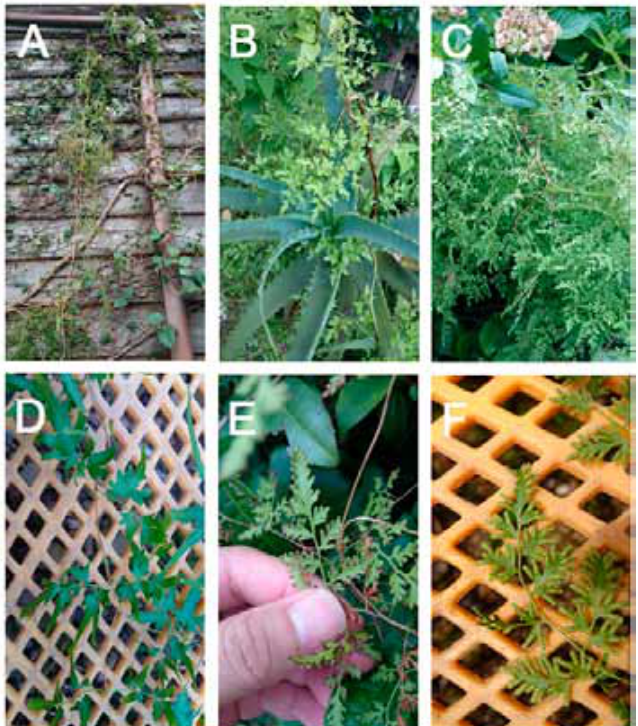
Fig. 5 - A climbing fern, Lygodium japonicum , found in a countryside private garden (Kiyotake-cho, Miyazaki, Japan). (A) Climbing growth of Lygodium japonicum on the wooden wall by com- peting with other climbing plants such as Ficus pumila . (B, C) Aggressive growth of Lygodium japonicum winning the compe- tition with other standing plants. (D) Vegetative leaflets. (E, F) Development of sporangia on dorsal side of the